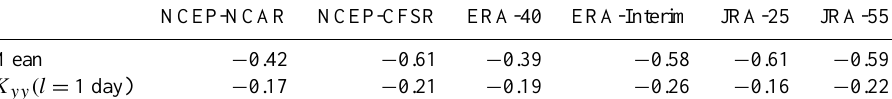
Table 9. Correlation coefficient between the 6-hourly mass stream function (Mean) at 50 ◦ N, 440K, and the 6-hourly E–P flux divergence at each grid point averaged between 500 and 650hPa and 50–60 ◦ N, and between K yy ( l = 1 day) at 50 ◦ N, 560K, and the 6-hourly E–P flux divergence at each grid point averaged between 550 and 650hPa and 45–55 ◦ N in DJF in 2001–2012 (1990–2001 for ERA-40).